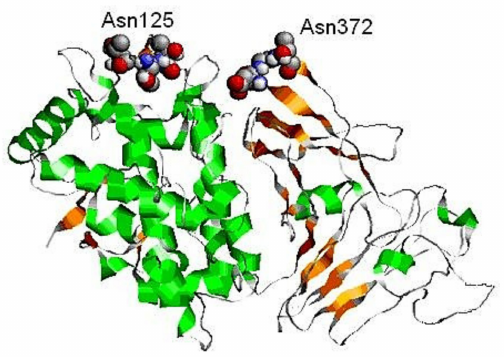
Figure 14. 3D-model of FU β c-HlH-g, built through the Swiss PDB viewer program and compared with the Octopus dofleini (OdH-g) FU model “g” [41]. Two possible glycosylation sites, to Asn125 and Asn245 residue, are indicated [41].